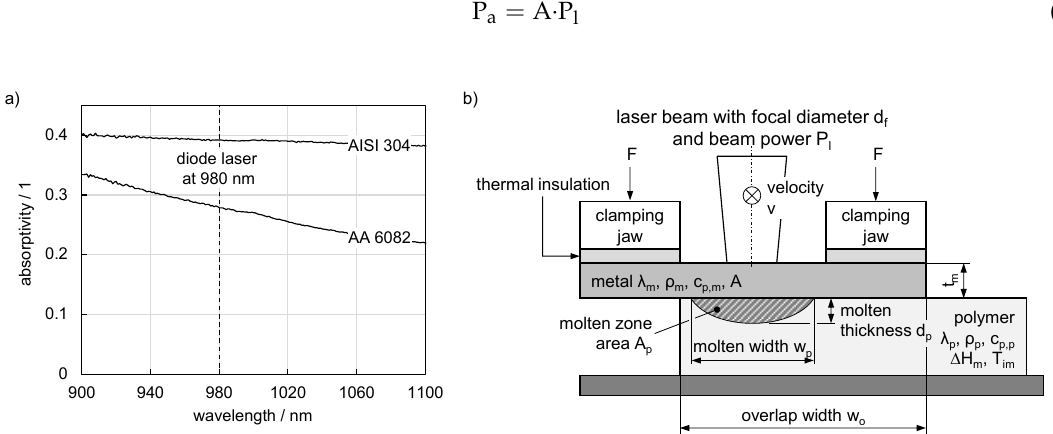
Figure 3. ( a ) Absorptivity and ( b ) schematic view of the joining zone with relevant parameters for thermal efficiency.